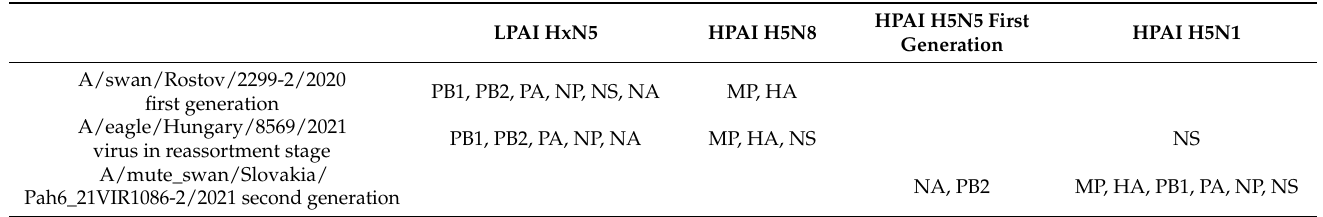
Table 2. Reassortment of genomic segments of subtype H5N5 avian influenza viruses identified in Europe and Russia in